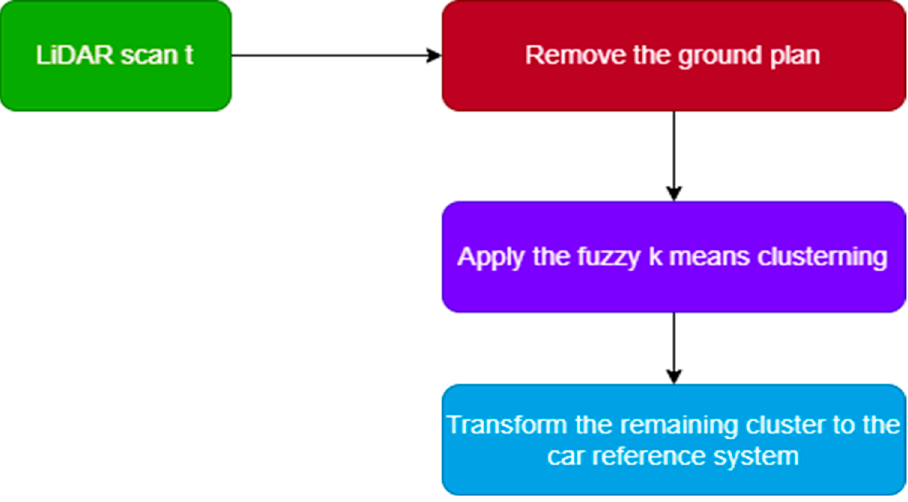
Figure 3 . Flowchart of the feature extraction from LiDAR measurement . Figure 3. Flowchart of the feature extraction from LiDAR